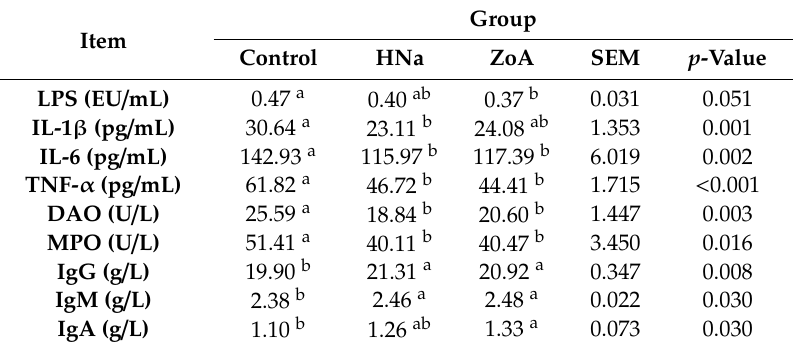
Table 3. E ff ects of HNa on serum cytokines and Immunoglobulin concentrations.